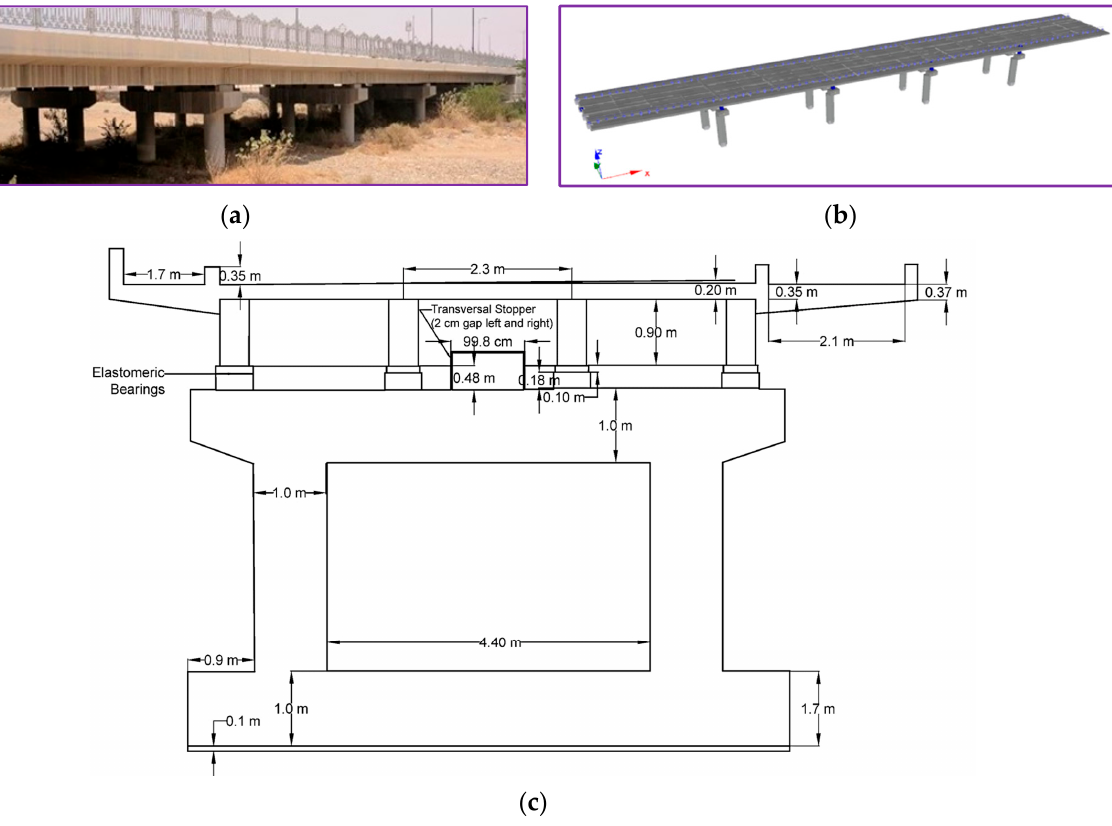
Figure 2. Benchmark bridge: ( a ) general view, ( b ) three-dimensional fiber-based (3DFB) model, and ( c ) bridge bent cross-sectional view.